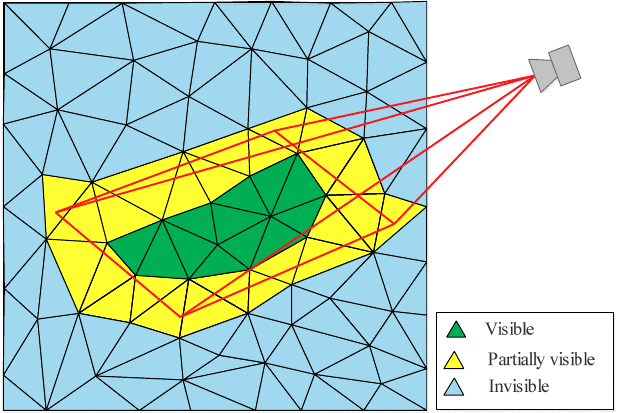
Figure 7. Triangular face classification. (1) Green means completely visible, (2) yellow means partially visible, and (3) gray means completely invisible.